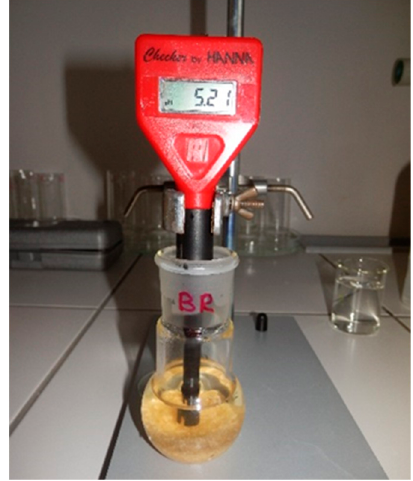
Figure 6. Measurement of the pH value using Checker in water extracts from sawdust.